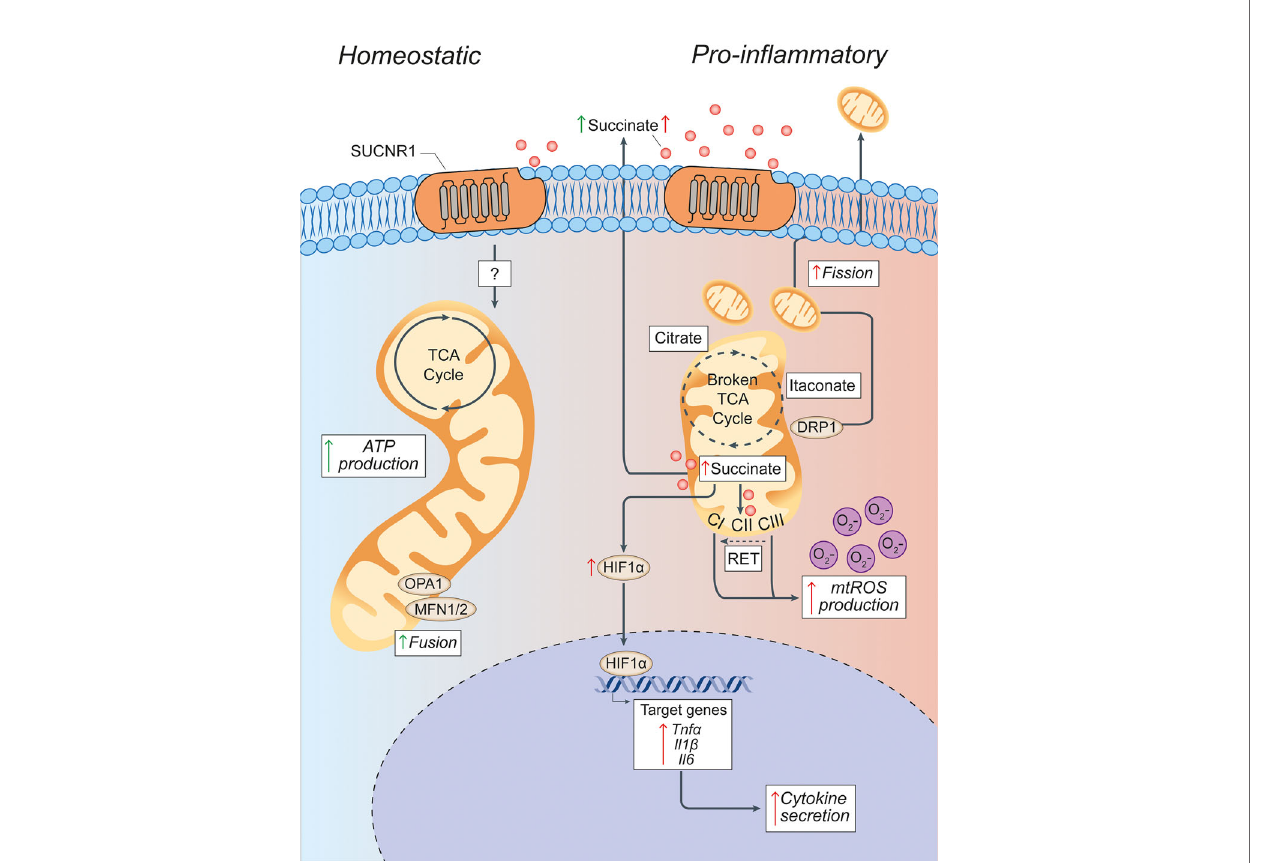
FIGURE 3 | Pro-in fl ammatory conditions lead to morphological and functional mitochondrial alterations of microglia. Microglia in homeostatic conditions have intact mitochondria with a functioning TCA cycle and conserved fusion of the mitochondrial network through OPA1 and MFN1/2 activities. Succinate signalling through SUCNR1 in homeostasis is presumably low, but its signalling functions in resting microglia are currently unde fi ned. In pro-in fl ammatory conditions, mitochondria undergo DRP1-mediated fi ssion and fragmentation, and show two breaks in the TCA cycle that lead to the intracellular accumulation of speci fi c metabolites (such as succinate, citrate, and itaconate). Succinate accumulation within mitochondria can drive RET, which produces excessive mtROS through complex I. This mitochondrial dysfunction creates a pseudohypoxic state that leads to the stabilization of HIF1 a and enhances cytokine production and secretion. Both fragmented mitochondria and succinate can be released into the extracellular environment where succinate can signal in an autocrine or paracrine manner via SUCNR1, thus modulating both anti-in fl ammatory and pro-in fl ammatory effects. Green arrows = anti-in fl ammatory effects; red arrows = pro-in fl ammatory effects. SUCNR1, succinate receptor 1; TCA, tricarboxylic acid cycle; OPA1, optic atrophy 1; MFN1/2, mitofusin 1/2; DRP1, dynamin-related protein 1; CI, complex I; CII, complex II; CIII, complex III; mtROS, mitochondrial reactive oxygen species; RET, reverse electron transport; ATP, adenosine triphosphate; HIF1 a , hypoxia inducible factor 1 a ; mtROS, mitochondrial reactive oxygen species; TNF a , tumor necrosis factor alpha; Il1 b , interleukin-1 b ; Il6,